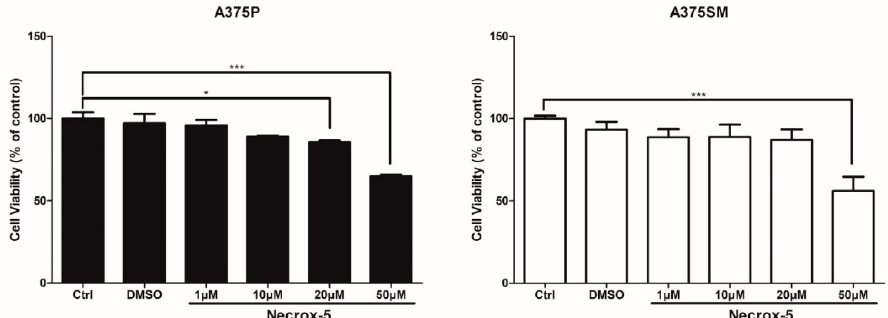
Figure 1. The effect of NecroX-5 treatment on cell viability in A375P and A375SM melanoma cells. Cells were treated with various concentrations of NecroX-5 for 24 h. Cell viability was measured using the MTT assay. Results are expressed as the mean ± SEM from the three independent experiments. * p < 0.05, *** p < 0.001.